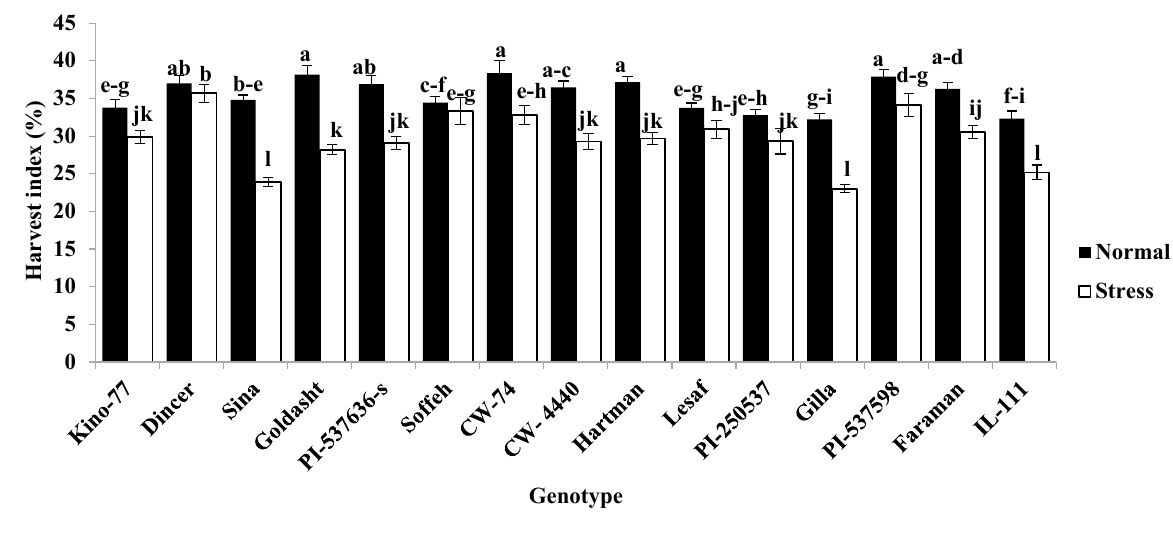
Fig. 4 Interaction effect of irrigation and genotype on harvest index. Mean values with the same letters are not significantly different ( p > 0.05) according to the Duncan test. Data are presented as mean ± SEM